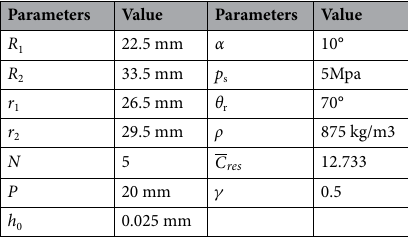
Table1. Parameters of the DDHSNP.